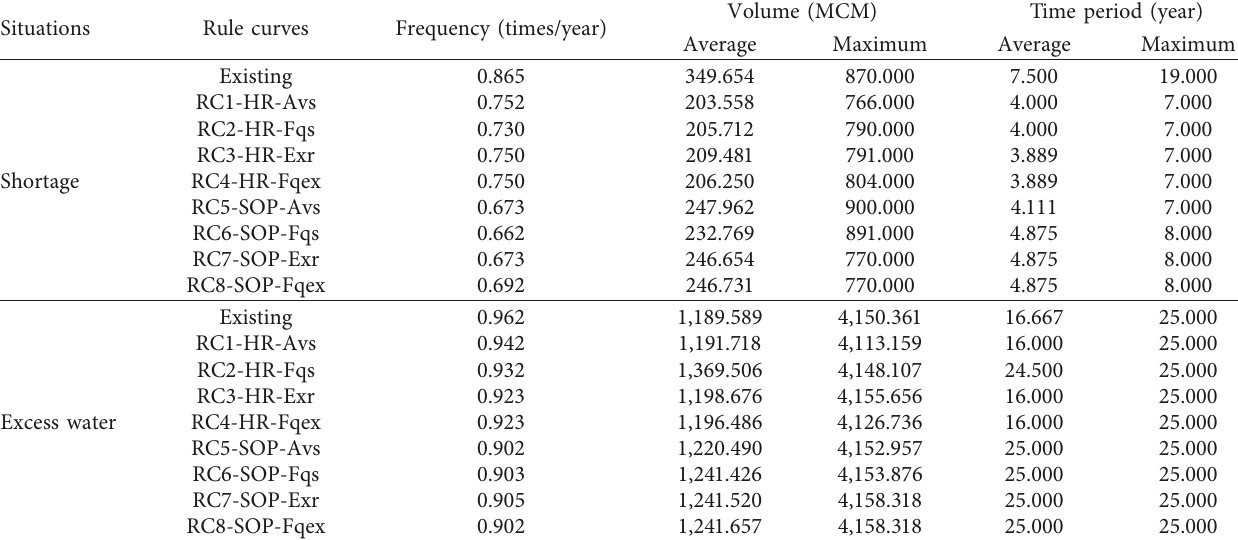
Table 3: The situations of water shortage and excess water considering historic inflow 52years using SOP